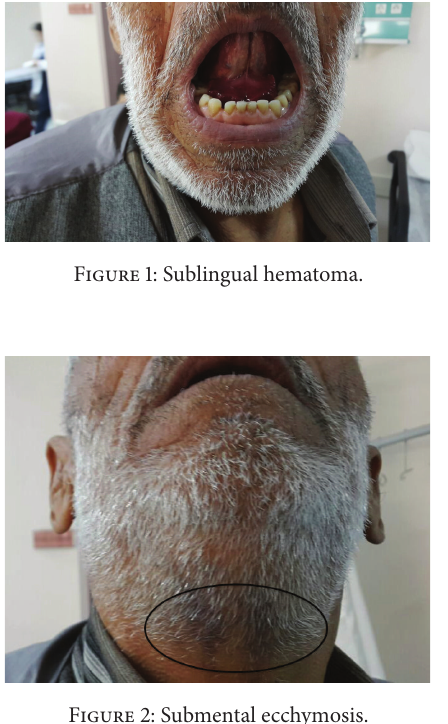
Figure 2: Submental ecchymosis.